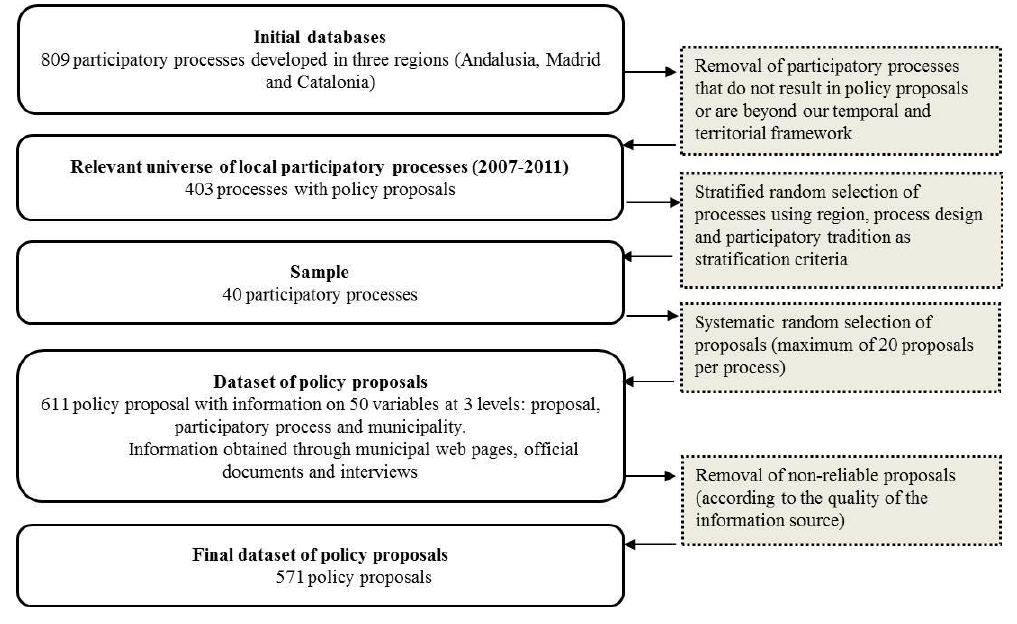
Figure 1: Methodological design: main